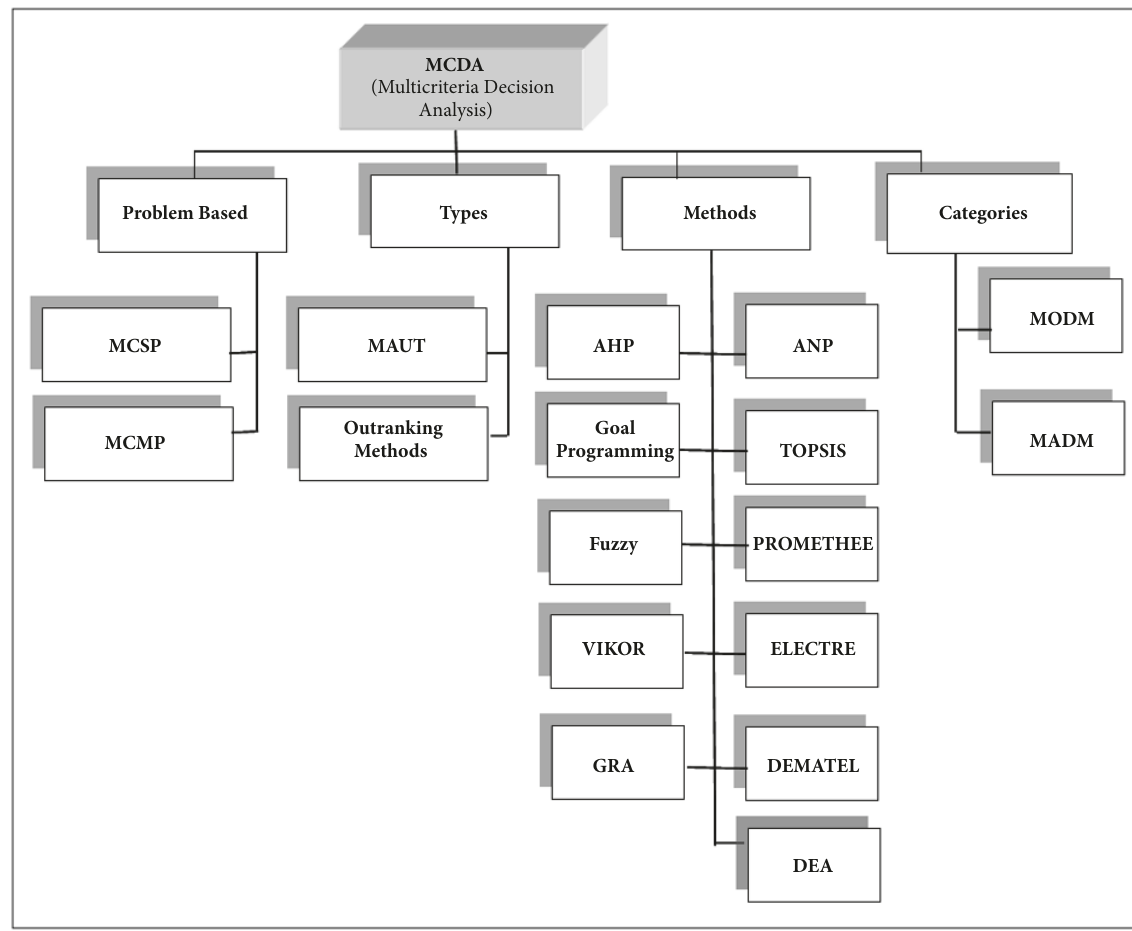
Figure 2: Different branches of